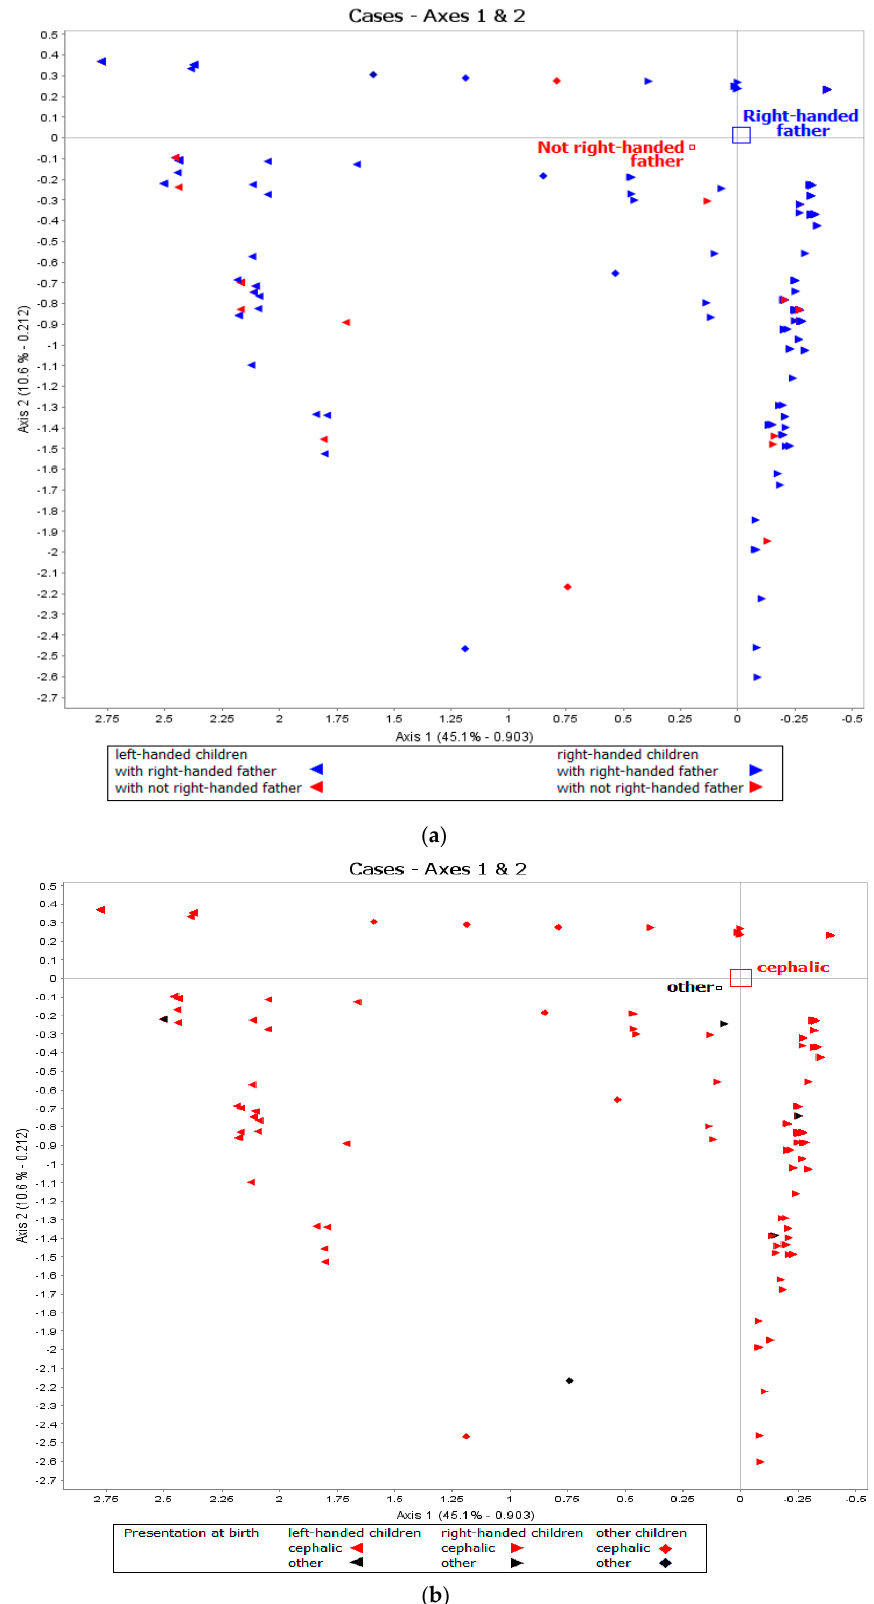
Figure 7. ( a ) Distribution of left-handed and right-handed children (X axis) as a function of father’s handedness (Y axis). ( b ) Distribution of left-handed and right-handed children (X axis) as a function of presentation at birth (Y axis). 90100 7080 d r Figure 8. Distribution of the 12% left-handed children at 5 as a function of fathers’ handedness and presentation and side of presentation ( n = 96). 0102030 4050 60 Left cephalic Right cephalic Left breech Right breech % o f n o n - r i g h t - h a nd e d c h il